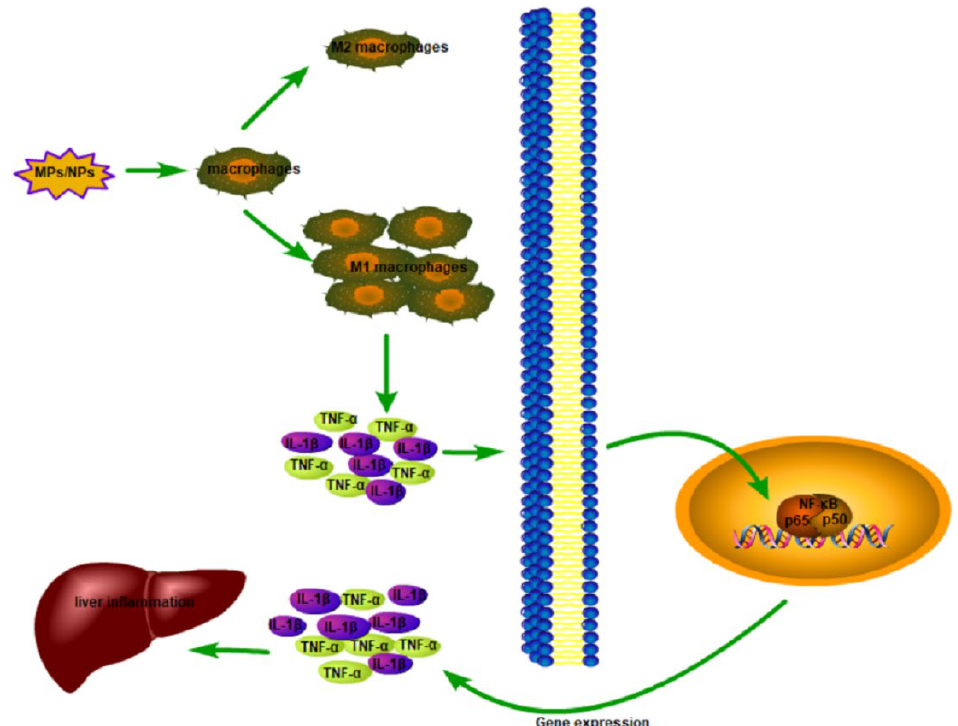
Figure 3. Schematic diagram of MPs/NPs-mediated inflammatory response. Table 5. The study parameters and effects of MPs and NPs on liver inflammation.